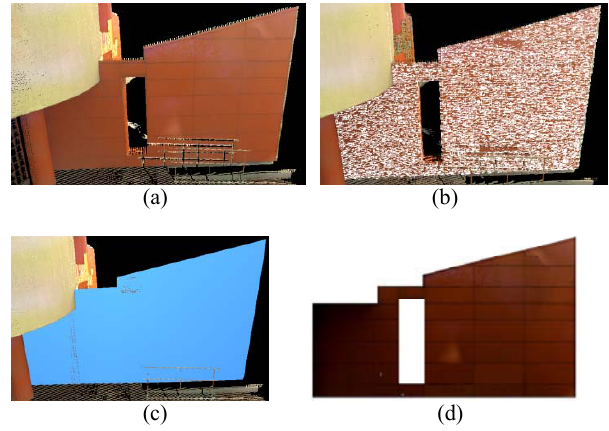
Figure 10. A plan that is part of the front façade of the building (a) Textured point cloud (b) Creating the patch in Cyclone software (c) Textured patch in Cyclone software using an aleatory color from the software palette (d) The surface textured in AutoCad by using the presented algorithm